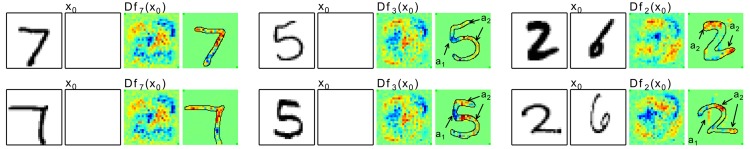
Taylor-approximated pixel-wise predictions for a multilayer neural network trained and tested on the MNIST data set.Each group of four horizontally aligned panels shows—from left to right—the input digit, the Taylor root point x
0, the gradient of the prediction function f at x
0 of a specific digit class indicated by the subscript next to f and the approximated pixel-wise contributions for x.